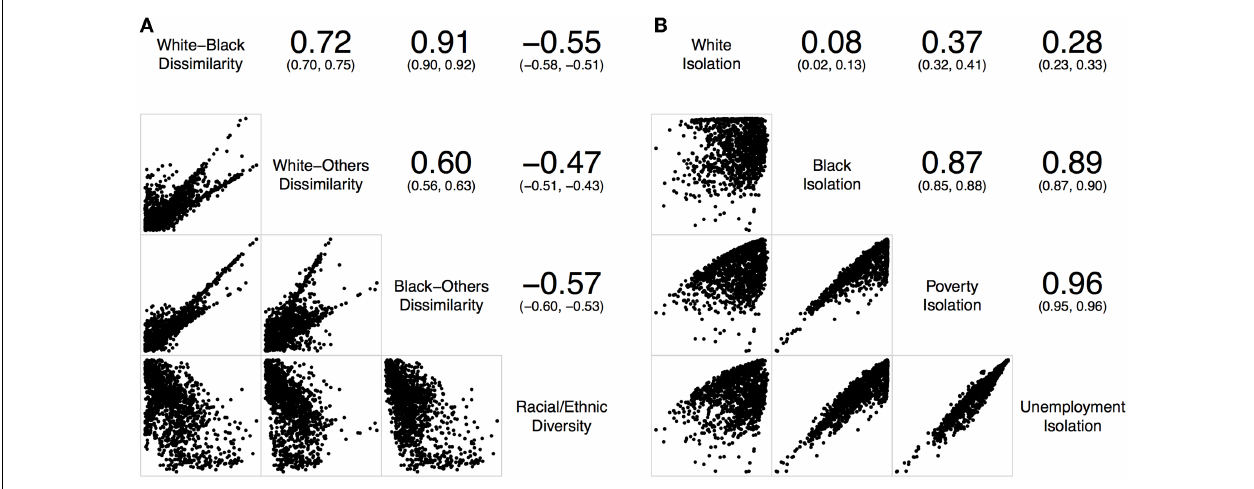
FIGURE 3 | Correlations of local spatial segregation measures in Chicago, IL, USA (1,327 census tracts) . (A) With respect to the evenness (i.e., dissimilarity and diversity) dimension, and (B) with respect to the isolation